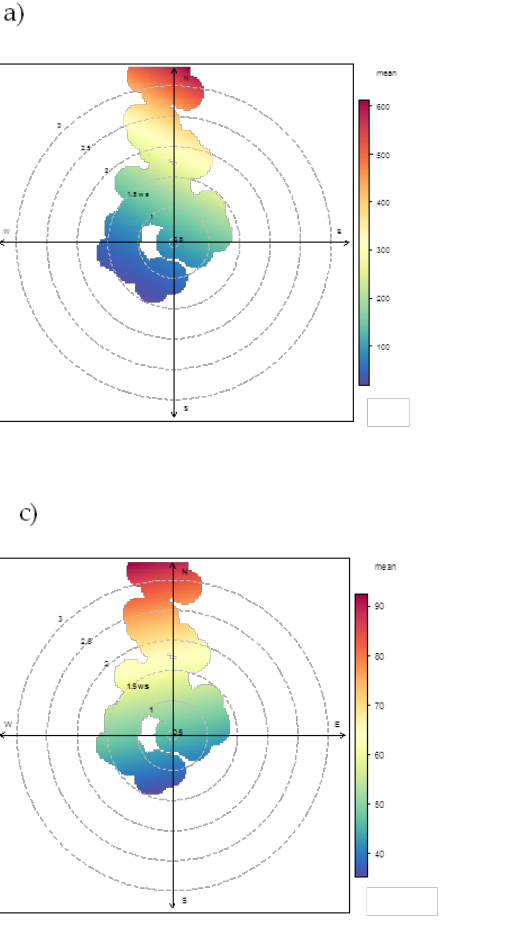
Figure 7. Polar plots of PMF outputs for the receptor sites downwind to Cokeria site: Parchi, Machiavelli, Tamburi and Adige. Factors: ( a ) “coke ovens”; ( b ) “homogenization / mineral park”; ( c ) “sintering”; ( d ) “traffic”.